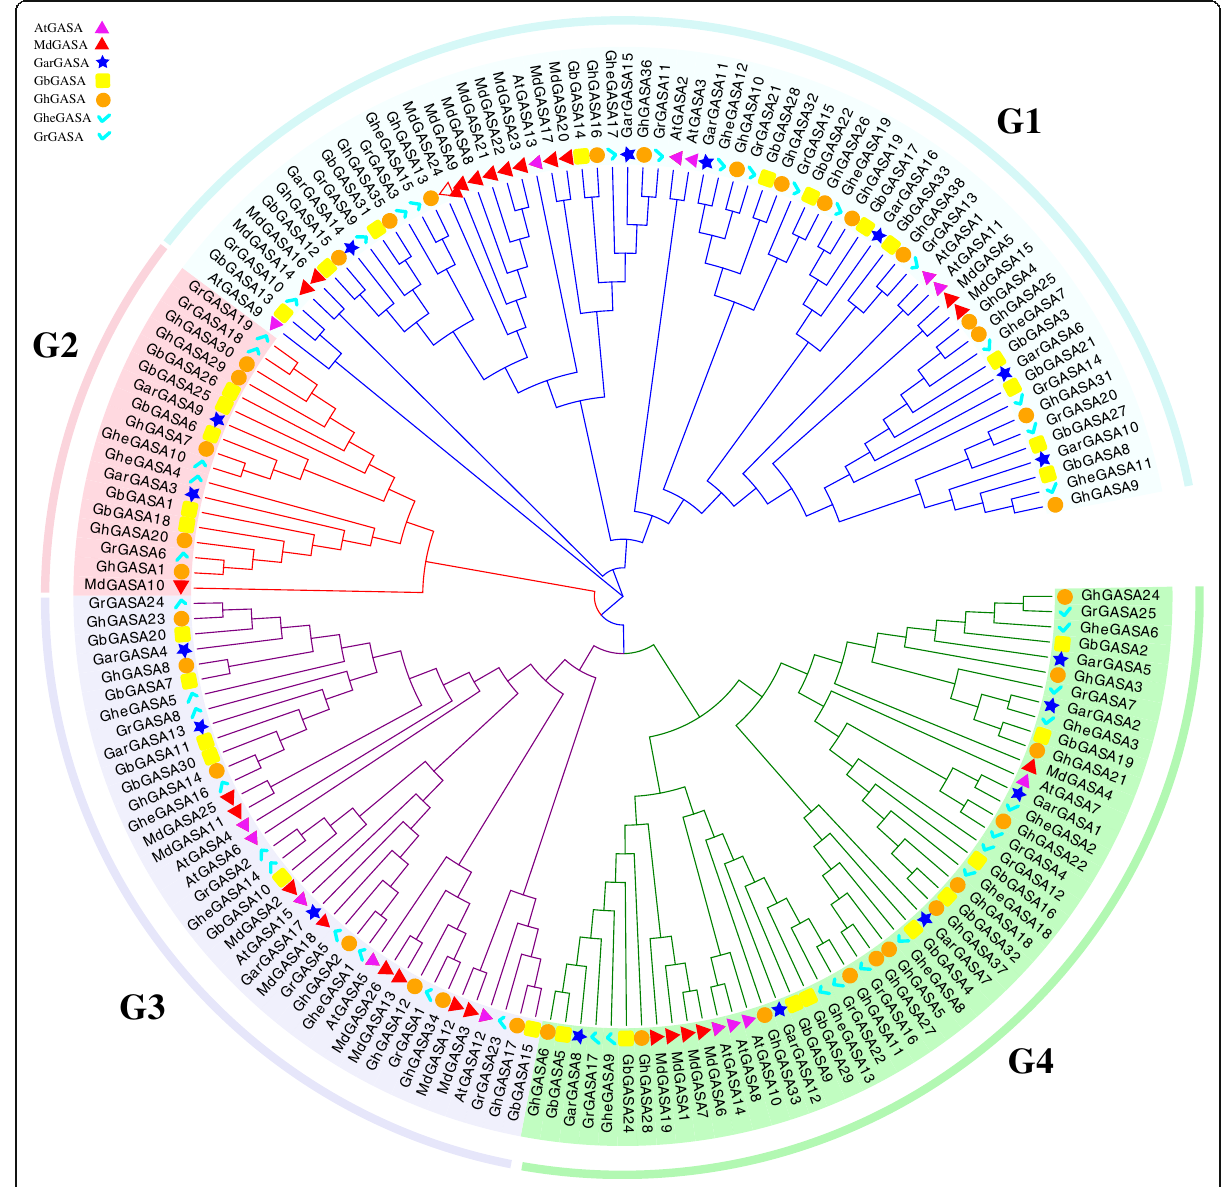
Fig. 2 Phylogenetic relationships among the GASA proteins. The four subgroups of GASAs are shown using four different